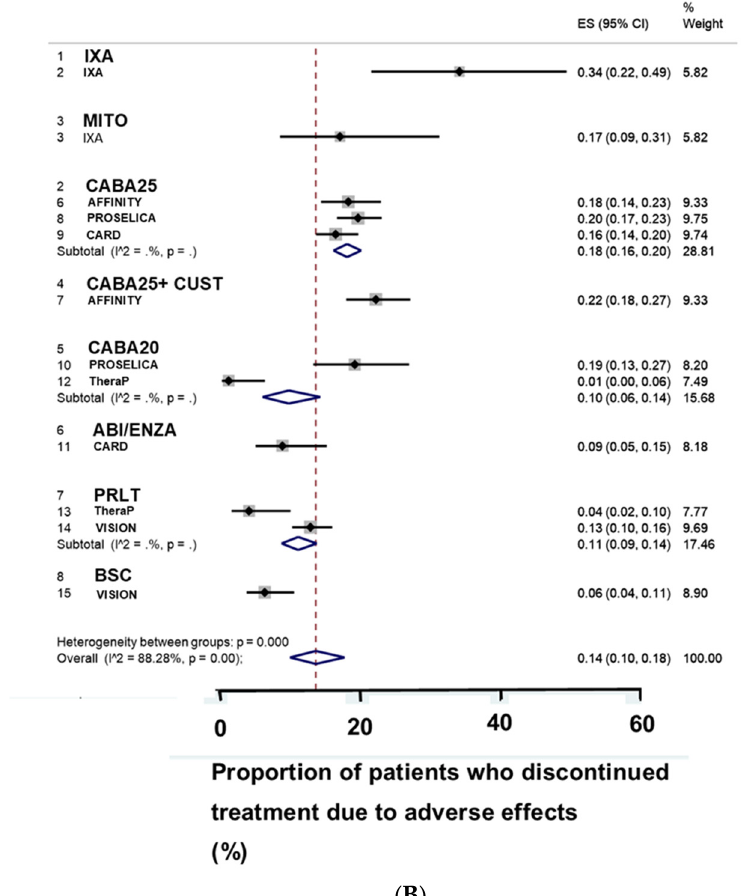
Figure 3. ( A1 ). The proportion of patients with severe anemia was higher after L3 treatment with a combination of cabazitaxel and custirsen than after treatment with ixabepilone, cabazitaxel as mon- otherapy, and PRLT. The proportion of patients with severe anemia was lowest with alternative abiraterone or enzalutamide and best supportive care. ( A2 ). The proportion of patients with severe leukopenia was higher after treatment with ixabepilone than after treatment with mitoxantrone, cabazitaxel 25 mg/m 2 body surface, and the combination treatment of cabazitaxel and custirsen. The proportion of patients with severe leucopenia was lower after treatment with cabazitaxel, the alter- native abiraterone and enzalutamide, and PRLT; ( A3 ) the proportion of patients with severe throm- bocytopenia was higher after treatment with the combination of cabazitaxel and custirsen than after treatment with cabazitaxel 25 mg/m 2 body surface and PRLT. The proportion of patients with severe thrombocytopenia was lowest after treatment with mitoxantrone and best supportive care. ( B ) The proportion of patients with premature discontinuation of treatment due to severe adverse effects was <10% after the L3 treatments. The proportion of patients with discontinuation of treatment was highest after treatment with ixabepilone and PRLT. treatment was highest after treatment with ixabepilone and